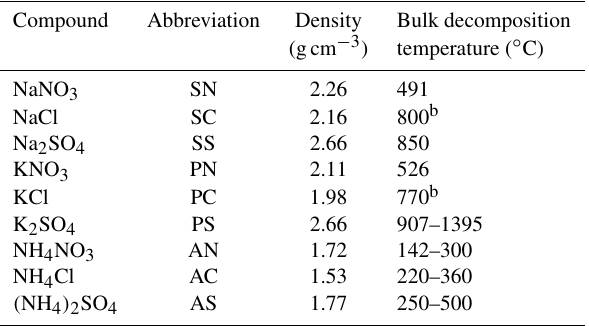
Table 1. Chemical compounds tested in this study a .